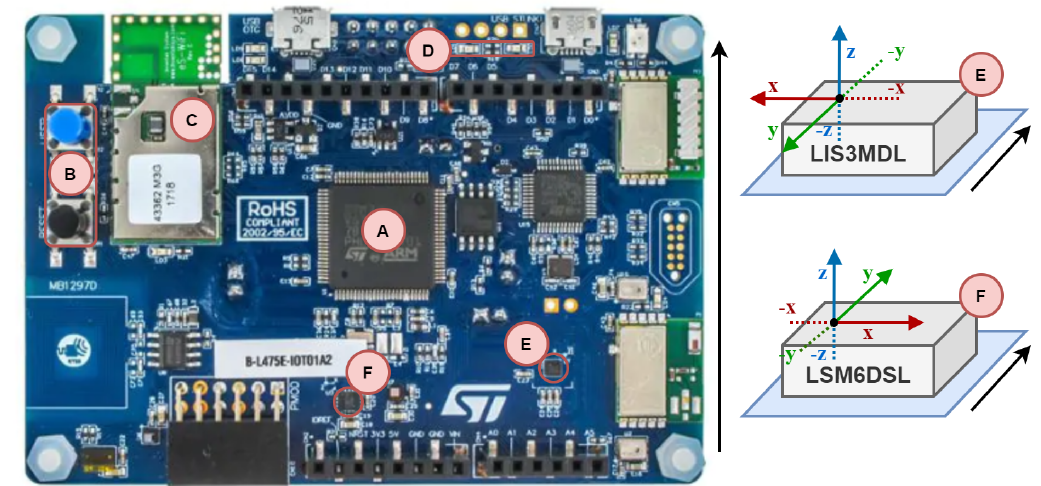
Figure 1. The printed board of B-L475E-IOT02A development board. (A: MCU, B: User button, C: Wifi module, D: LEDs, E: 3D Magnetometer, F: 3D Accelerometer and Gyroscope).